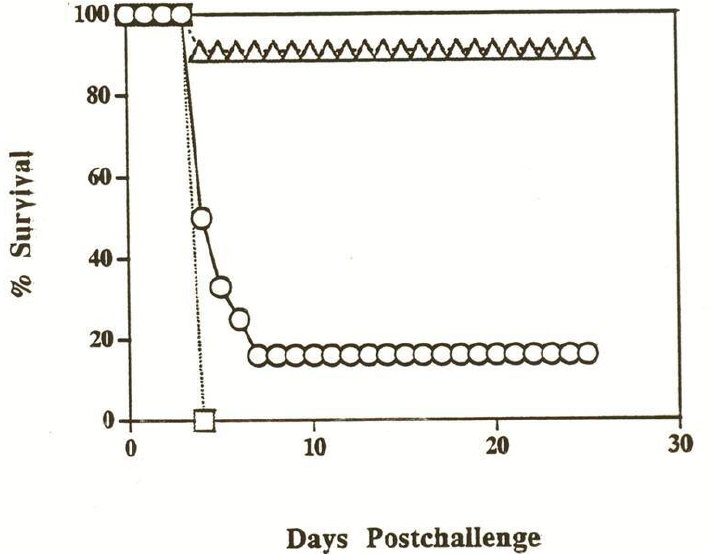
Figure 2. Percentage (%) of rat survival immunized with RT encapsulated (triangle) or in PBS for 1 dose (square) and 3 dose (circle)